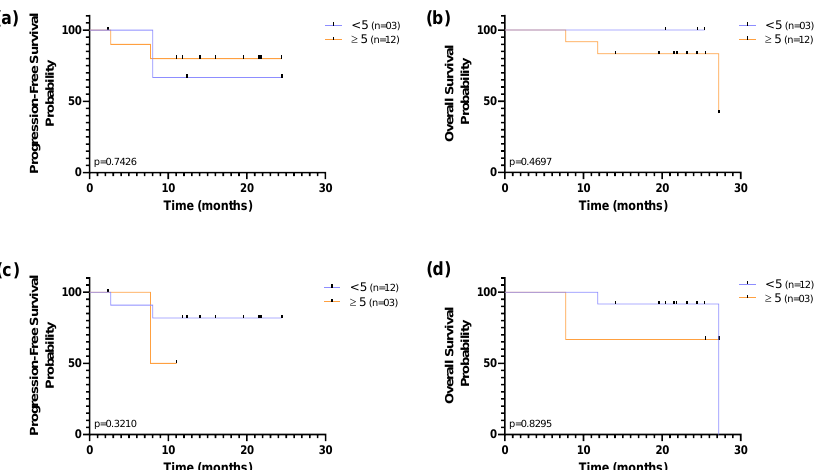
Figure 7. Kaplan–Meier curves of progression-free survival (PFS) and overall survival (OS) according to CTC count (≥5 CTCs/7.5 mL of blood), using ( a , b ) RUBYchip™ and ( c , d ) CellSearch ® for isolation of CTC in MBC patients. PFS and OS were calculated from the time of the baseline blood collection. Differences in survival curves were determined using the log-rank test. Regardless of the isolation methodology, overall survival curves plateaued above 50% risk of survival, and sharp decreases to the probability of survival were observed only by the end of the study, indicating that a substantial proportion of patients survived for longer than the follow-up period, throughout the study. Although it may be indicative that there are very few patients at high risk at baseline, this small and heterogeneous co- hort limits our ability to reach significant results based on one single time point. Never- theless, accounting for CTC enumeration across the two time-points, the population was dichotomized as favourable when CTC counts were (i) below 5 CTCs at baseline and fol- low-up or (ii) above 5 CTCs at baseline, but below 5 CTCs at follow-up; and unfavourable when (i) above 5 CTCs at baseline and follow-up or (ii) below 5 CTCs at baseline, but above 5 CTCs at follow-up. The CellSearch ® detection method was not able to discriminate subpopulations in this cohort, since only a single patient was considered to have unfa- vourable CTC counts. Out of the 15 patients, using the RUBYchip™, discrimination of populations was well-defined with 40% that had favourable prognostic CTC counts and 60% with unfavourable CTC counts. Although no significant association between distinct subpopulations detected by RUBYchip™ and the survival measures was found ( p = 0.3718, LogRank test), patients showing unfavourable CTC counts tended to have de- creased survival (Figure 8).